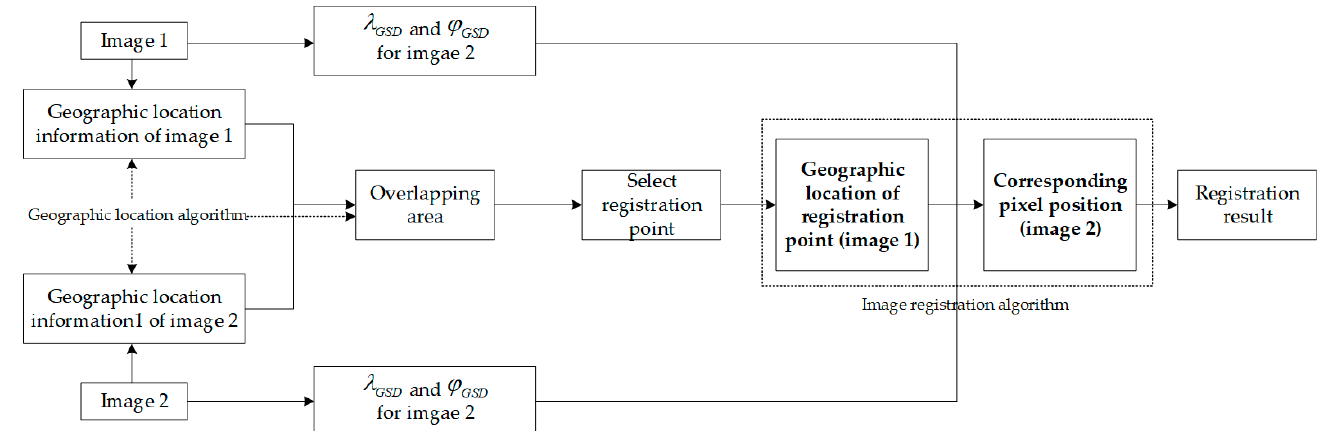
Figure 6. Overall flow diagram of the algorithm.